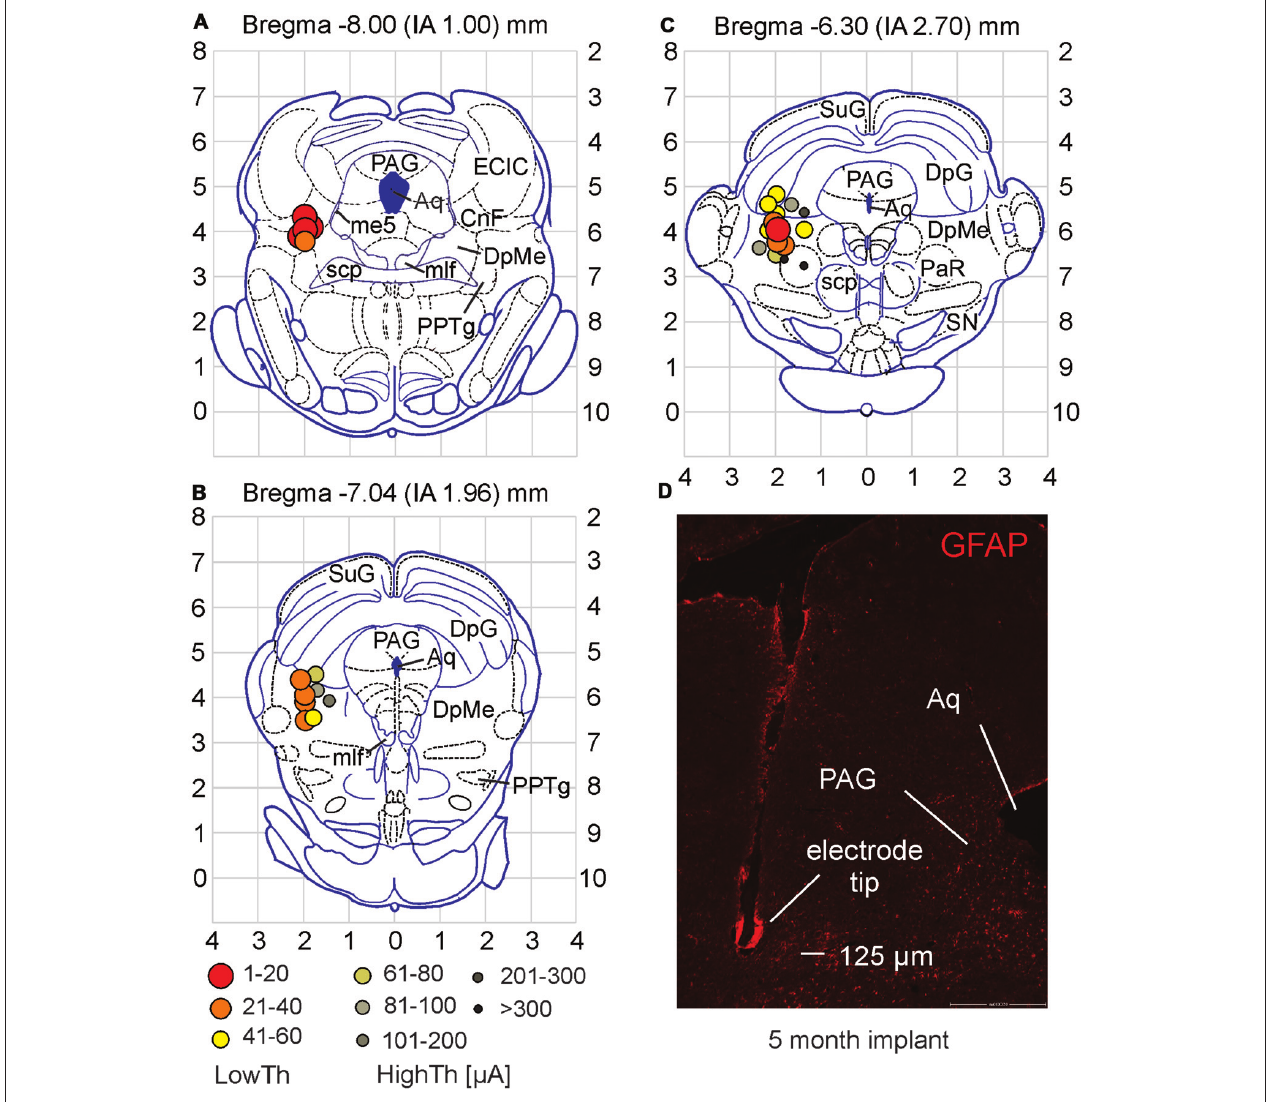
FIGURE 3 | Stimulation sites for high and low current locomotor threshold groups differ in location. (A–C) Low threshold sites were found in the CnF and DpMe of midbrain. High threshold sites were observed surrounding these areas. Current thresholds for each site are defined by symbols in (B) . (D) Example of electrode tip site in the brain tissue (coronal section). Note the minor tissue response to the electrode as observed with GFAP staining. Abbreviations as per Paxinos and Watson (1998). Aq, aqueduct; CnF, cuneiform n.; DpG, deep gray layer of superior colliculus; DpMe, deep mesencephalic n.; ECIC, external cortex of inferior colliculus; me5, mesencephalic n. of 5th nerve; mlf, medial longitudinal fasciculus; PAG, periaqueductal gray; PaR, pararubral n.; PPTg, pedunculopontine tegmental n.; scp, superior cerebellar peduncle; SN, substantia nigra; SuG, superficial gray layer of superior colliculus.